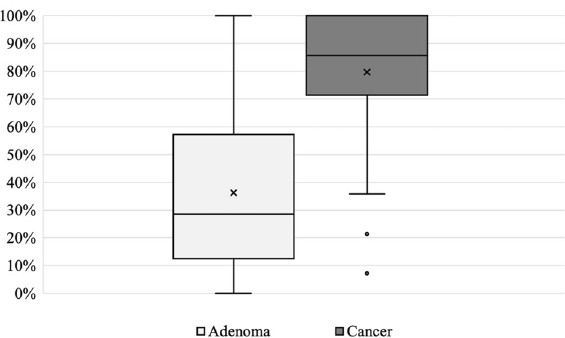
Figure 1. Distribution of accurate diagnosis in 50 gastric adenomas and 50 gastric cancers. The left side axis shows the percentage of endoscopists whose diagnosis with C-WLI + M-NBI was consistent with pathology.